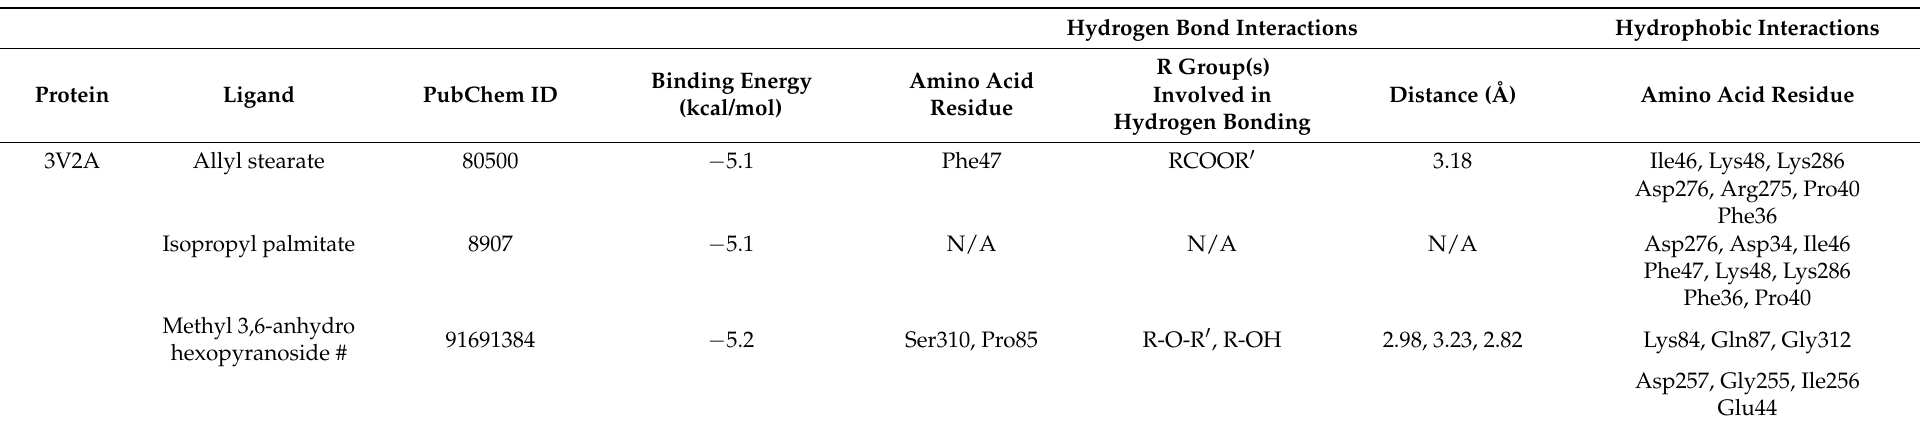
Table 7. Binding energy of potential bioactives on VEGFA (PDB ID: